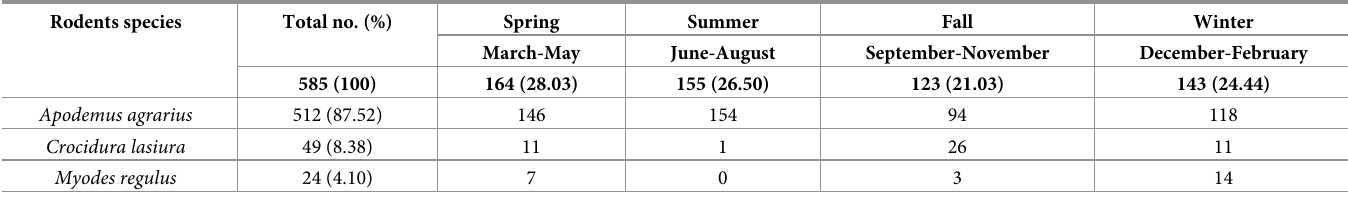
rodents were captured in spring, summer, fall, and winter, respectively. The species of cap- tured rodents were Apodemus agrarius (striped field mouse; 512, 87.52%), Crocidura lasiura (big white-toothed shrew; 49, 8.38%), and Myodes regulus (royal vole; 24, 4.10%) (Table 2). Nested RT-PCR targeting the hantavirus L segment was performed using lung specimens from wild rodents. Of the 585 rodents, 11 (1.88%) were PCR-positive for hantaviruses. Viral Table 2. Seasonal distribution of wild rodents captured in Gwangju Metropolitan suburban areas from 2016 to 2018. Rodents species Total no.